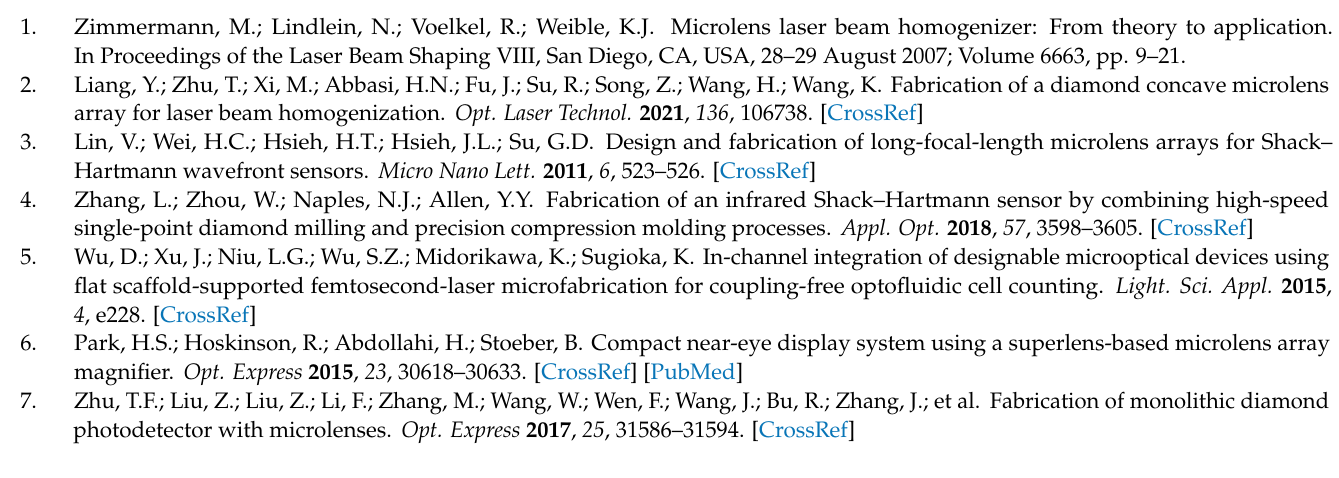
Figure A2. The Rayleigh–Sommerfeld (RS) diffraction integral, Equation (1). Calculation of the axial linearity distribution (normalised) at different wavelengths λ for the fixed refractive index n SZ 2080 = 1.504. Simulations for the visible 633 nm wavelength using the same approach is shown in Figure